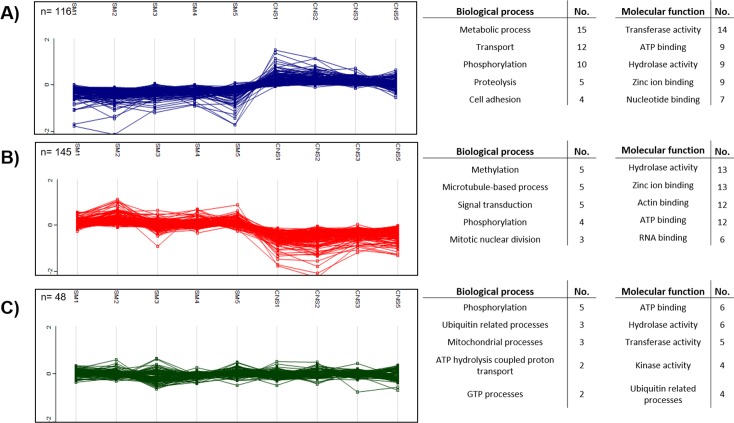
k-means clustering and associated biological/molecular functions for proteins of skeletal muscle (SM) and central nervous system (CNS) cysts.Cluster associated with the CNS (A), SM localization (B) and 48 constitutive proteins with the lowest coefficient of variation (C). The proteins included have a P-value <0.01 (n = 261). Only the most frequently observed categories and molecular functions (obtained using Argot2 algorithm) are show on the right panel. The y axis shows the Log2 (relative abundance).